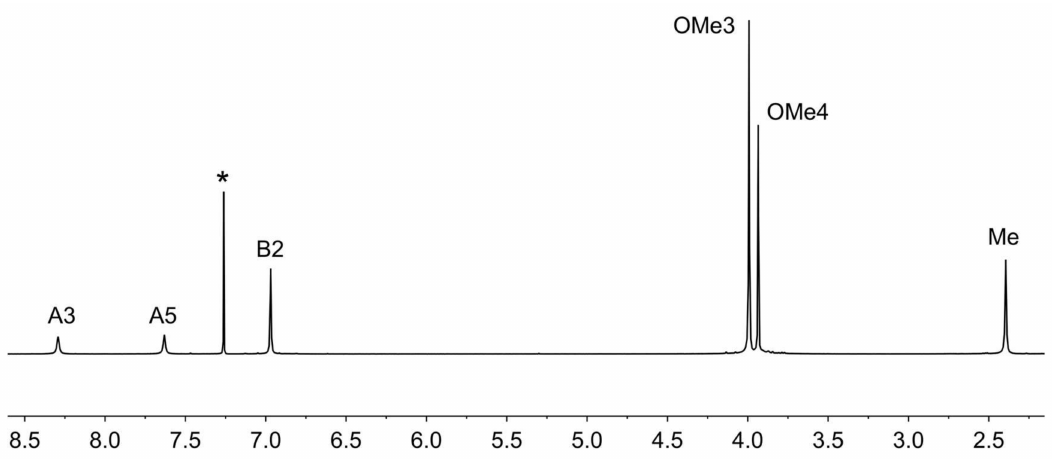
Figure 1. The 500 MHz 1 H NMR spectrum of [Cu( 4 ) 2 ][PF 6 ] (CDCl 3 ). * = residual CHCl 3 . Chemical shifts in δ /ppm. See Scheme 1 for labelling.